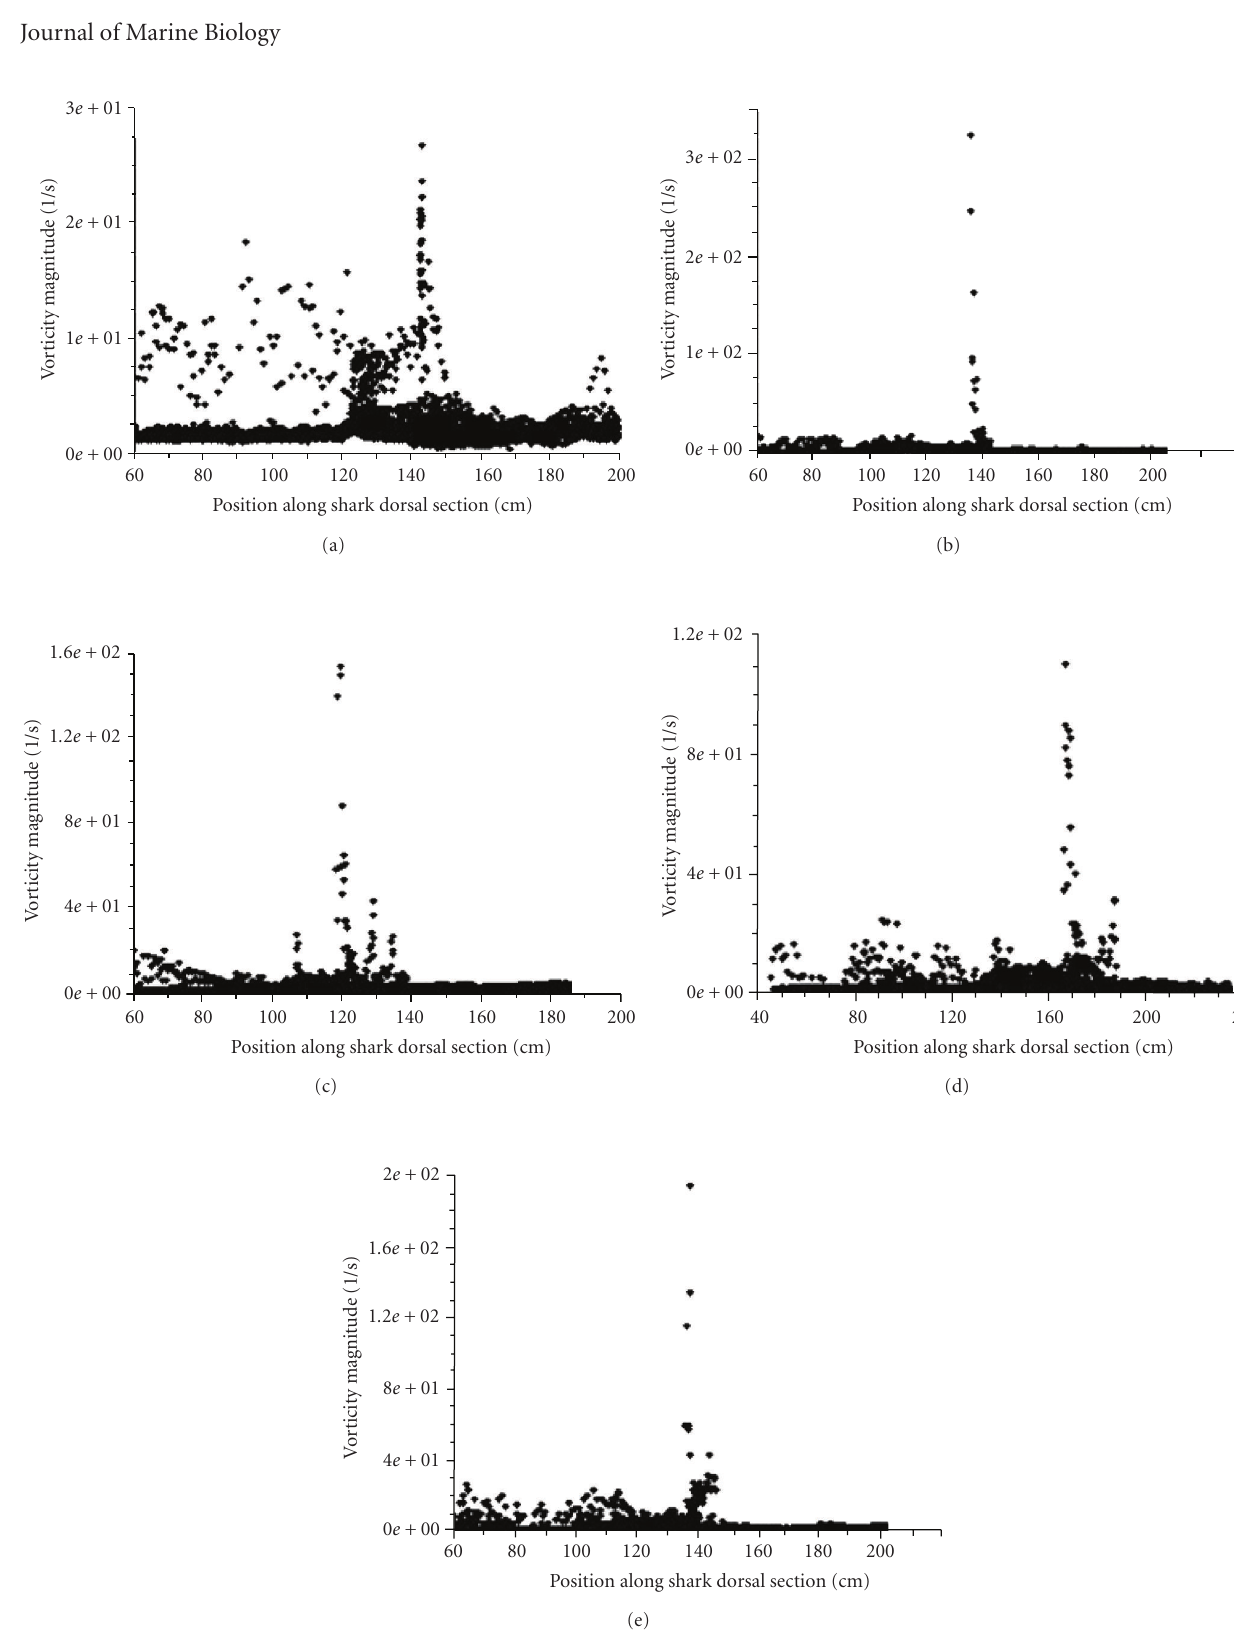
Figure 9: The vorticity magnitude on the body surface of the shark dorsal fin section models (a)–(e). The x -axis on the figure represents the y -axis along the shark dorsal section models and the y -axis shows the vorticity magnitude at every position on the shark at that particular y value. In this way, the figure shows the maximum vorticity magnitude at each position along the shark body model, clearly illustrating the vorticity spike at the dorsal fin trailing edge in each